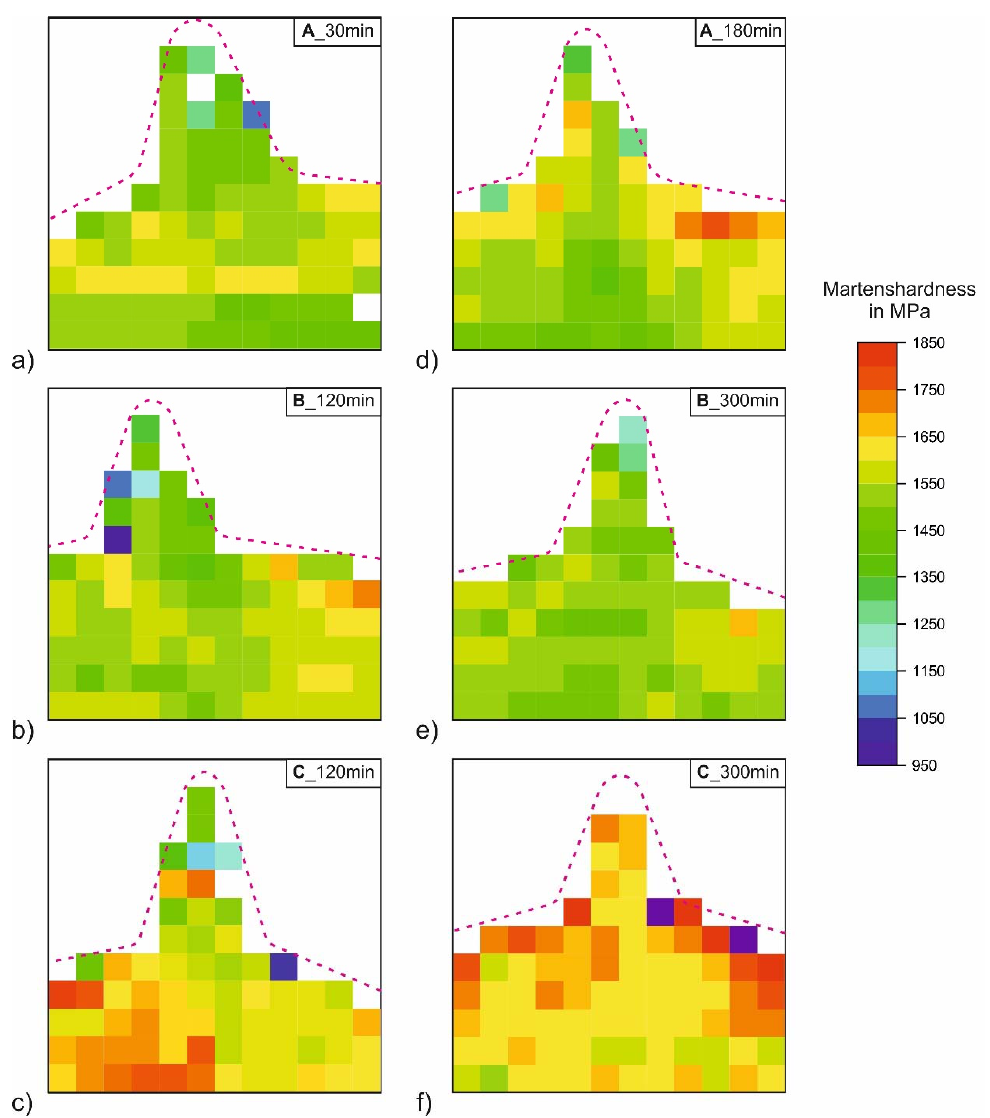
Figure 6. Distribution of Martens hardness over the metallographically polished longitudinal section of the differently processed threaded parts after thread rolling. Schematic contours of thread teeth marked with dashed line in pink. Processing route and initial heat treatment: ( a , b ) processing route A (initially solution-annealed), ( c , d ) processing route B (initially naturally aged), ( e , f ) processing route C (initially pre-aged). Artificial aging time: ( a – c ) local hardness maximum and ( d – f ) global peak-hardness achieved. In general, the hardness of the thread root is significantly higher than of the thread flank. The highest overall hardness is achieved by processing route C (pre-aging as initial heat treatment).